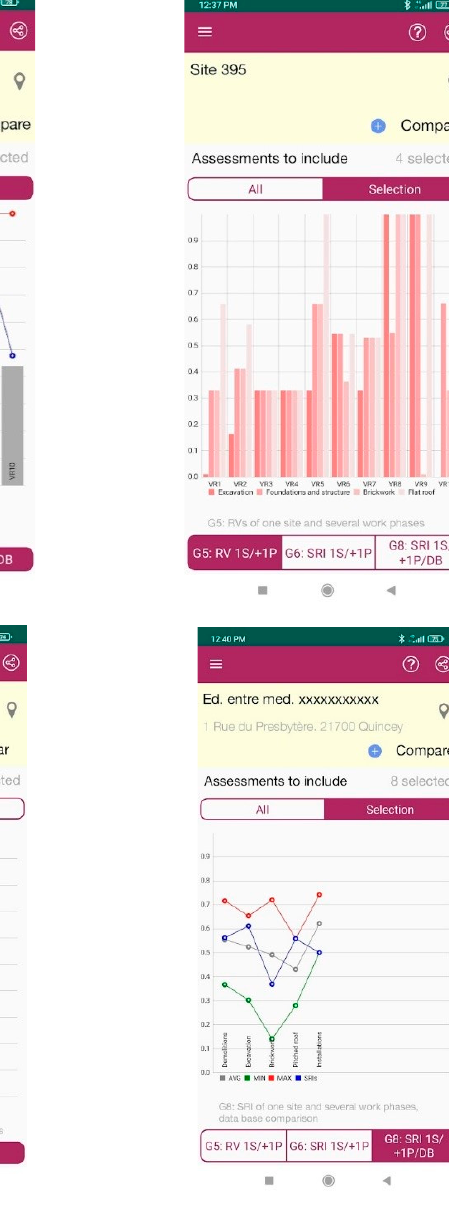
Figure A4. Graphs for control and monitoring of the level of risk that facilitates the application. Source: App screenshots.